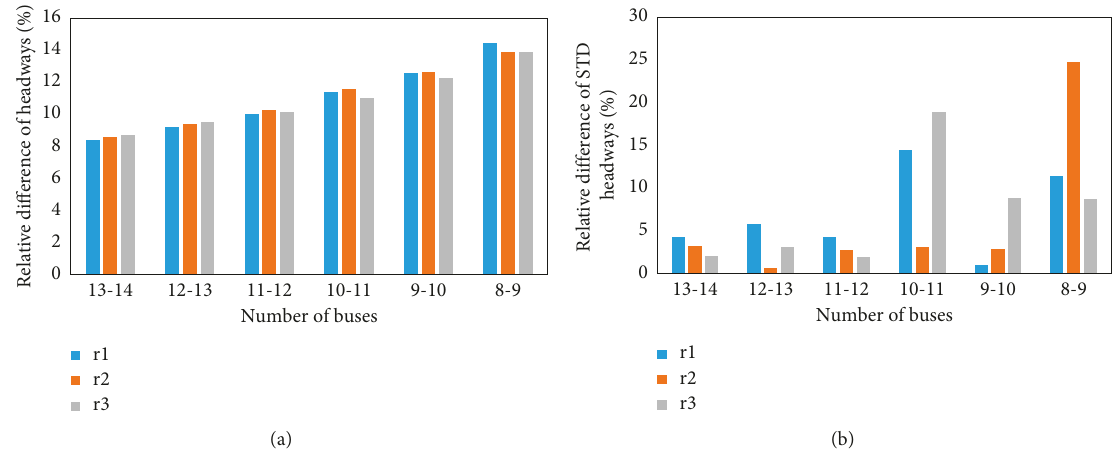
Figure 12: Index of bus headways along with increasing buses on the route. (a) Relative difference of headways. (b) Relative difference of STD